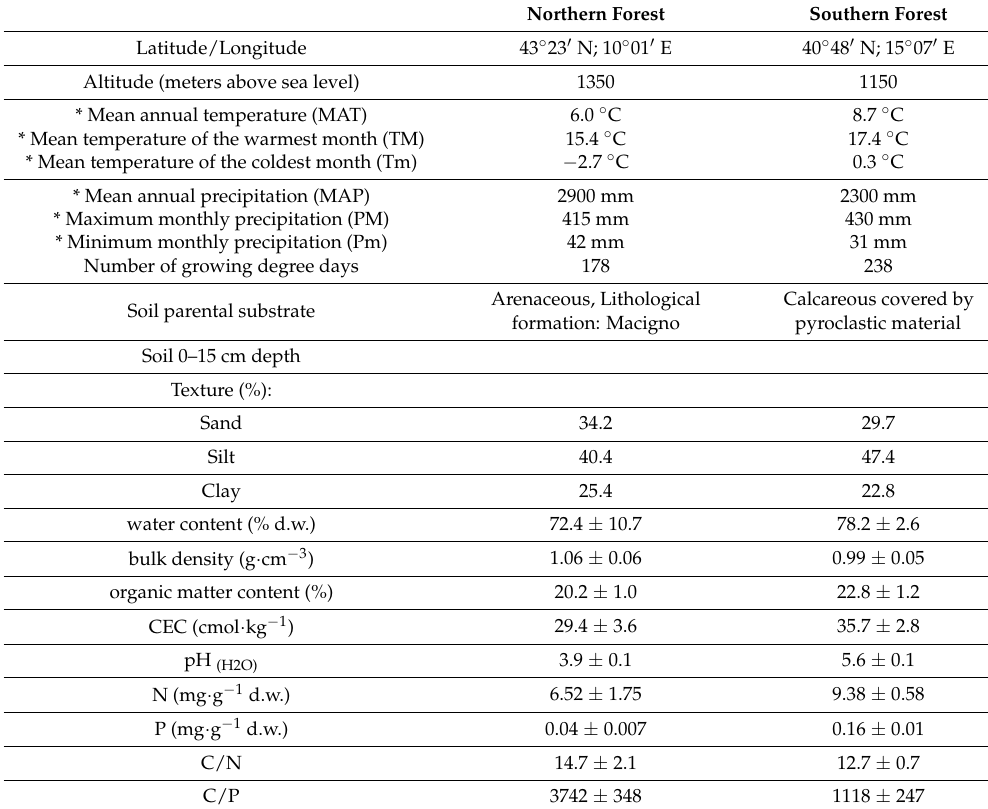
Table 1. Location, climate and soil features of two 75-year-old beech forests in the Apennines mountains